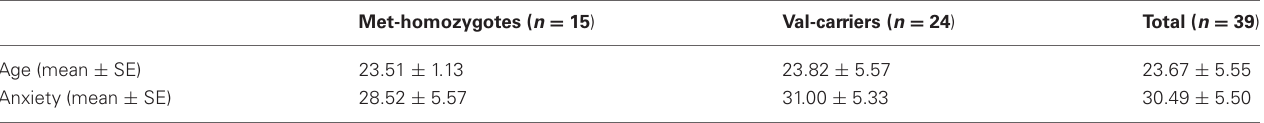
Table 1 | Participant demographics.